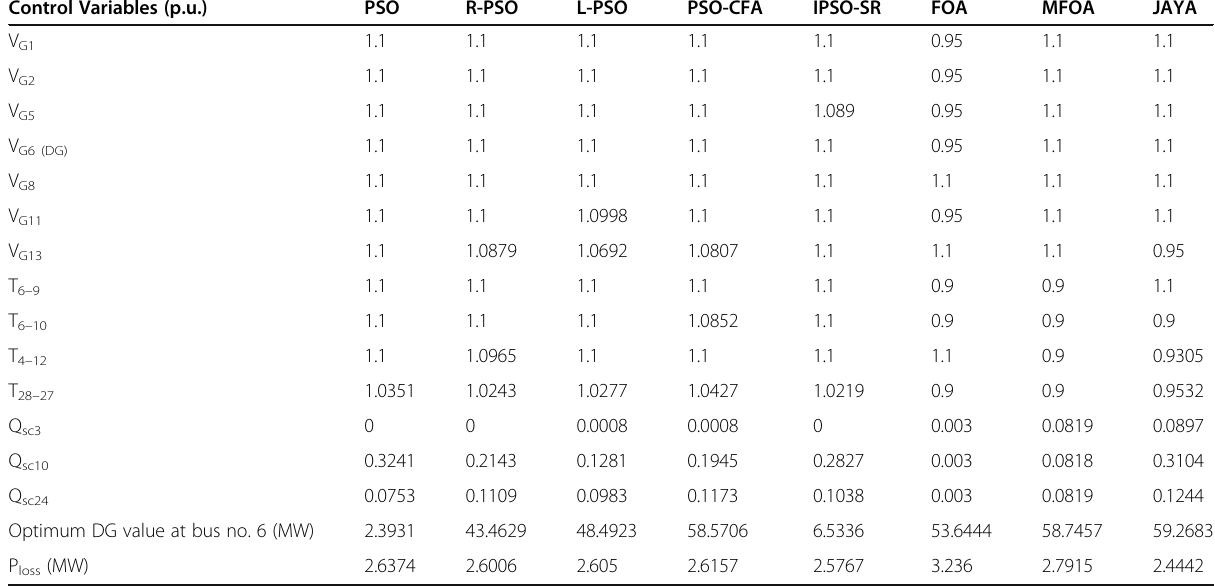
Table 17 Simulation results on the IEEE 30 bus system with overestimated Weibull probability distribution function of wind power on ORPD using different algorithms Control Variables